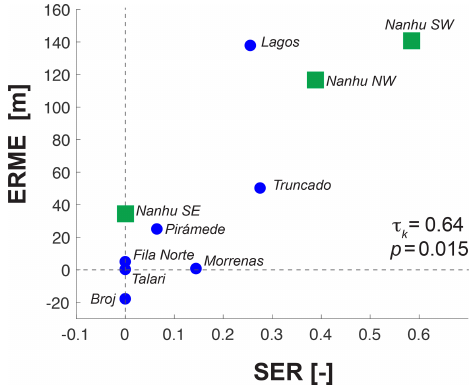
Figure 12. ELA-relative modal elevation (ERME) and scarp en- croachment ratio (SER) for each catchment at Chirripó (blue) and Nanhudashan (green) (names found in Fig. 11). Kendall’s tau (0.64) reported for the entire data set. One-tailed significance test yields a p value of